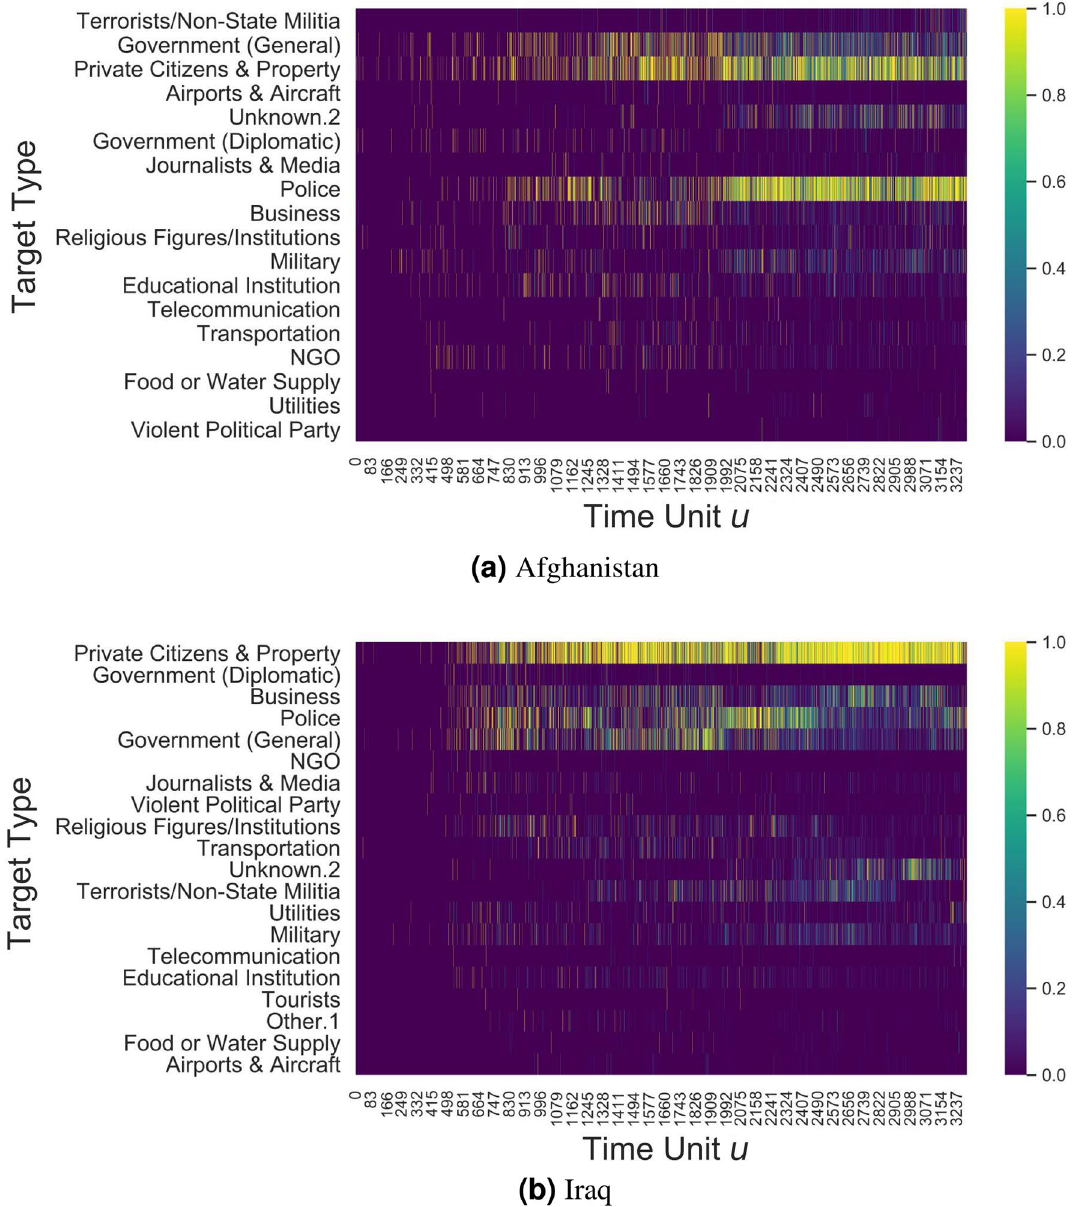
Figure 5. Temporal evolution of centrality in the target dimensions ( D Y ) for the Afghanistan and Iraq cases. The figures have been created using Matplotlib version 3.1.3. https:// matpl otlib. org/3. 1.3/ conte nts.